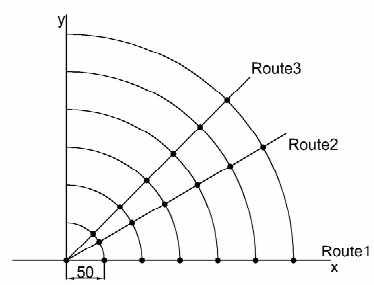
Figure 5. Schematics of different moving tracks of pick-up coil.